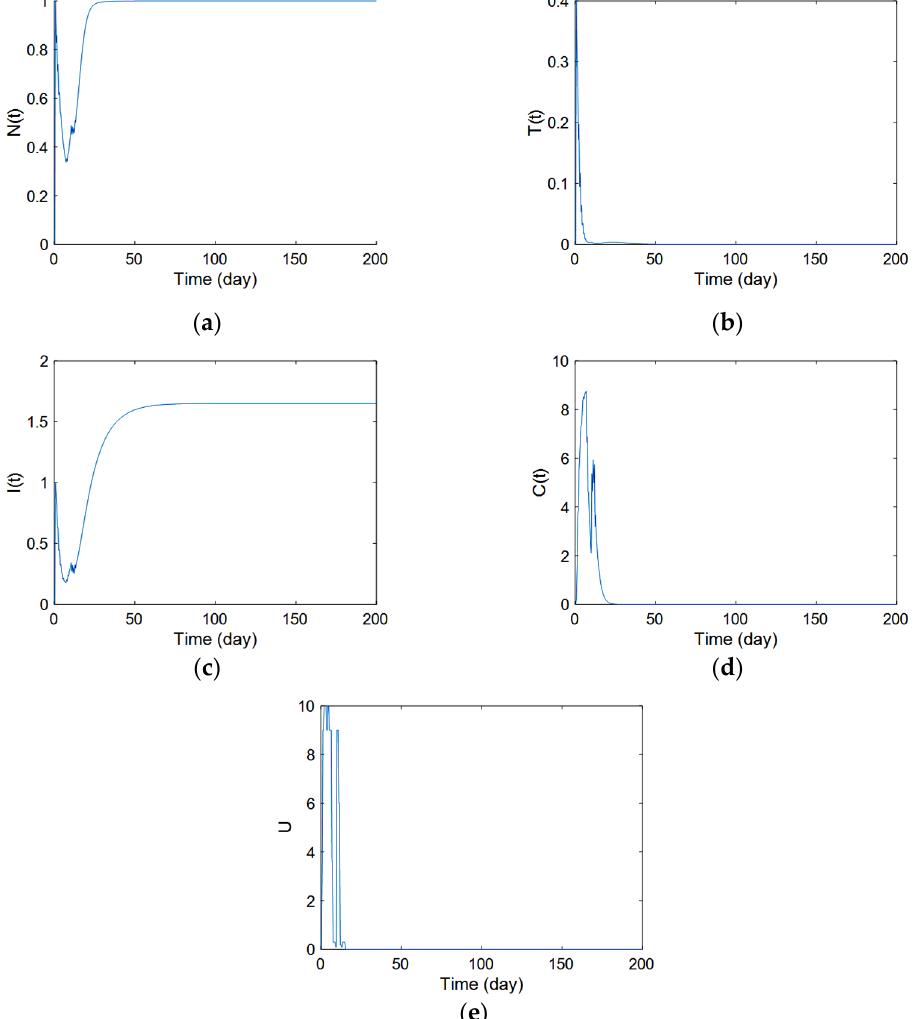
Figure 6. The result of simulation using the proposed control method for elderly patient without uncertainty. ( a ) Normal-cells ( b ) Tumor-cells ( c ) Immune-cells ( d ) Concentration of cells ( e ) Control action.